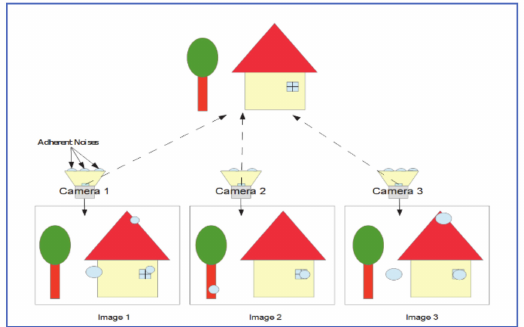
Figure 10. Adherent raindrops are not likely to cover the same areas of an image using different cameras [28].